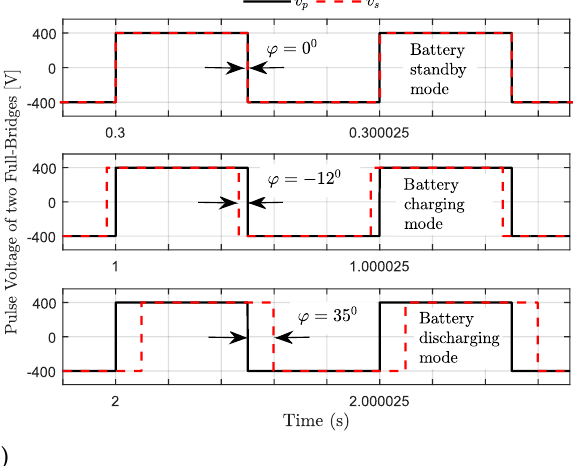
Figure 10. Simulated Case I: ( a ) SoC of the battery and phase–shift control; ( b ) Pulse voltage of two Full–Bridges, v p and v s .